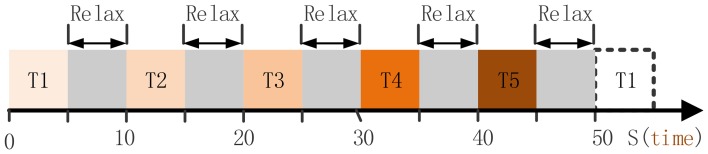
The full run experiment of subject P1. T1, hand unfold; T2, hand grasp; T3, thumb-finger motion; T4, wrist motion; T5, index-finger motion. Each trial lasts 5 s, thereby 50 s were needed for the full run.